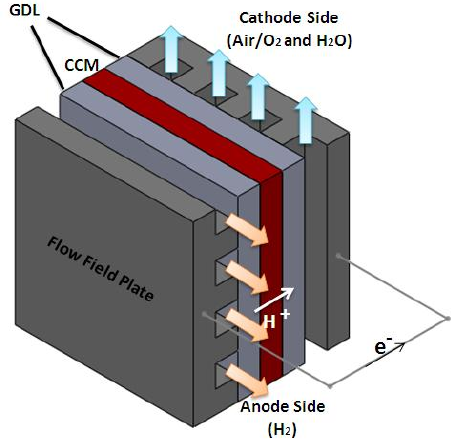
Figure 1. Schematic of a hydrogen PEM fuel